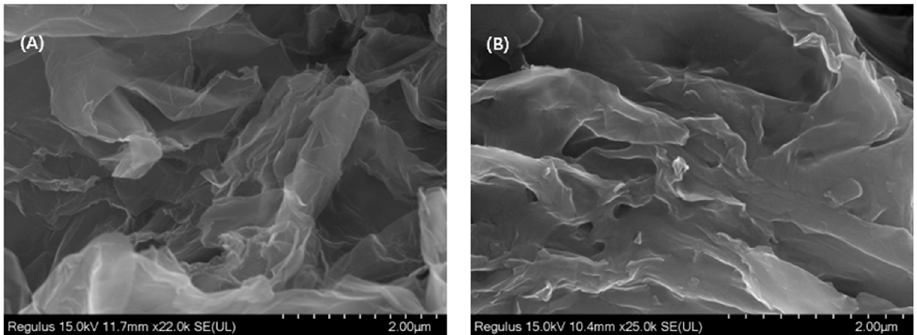
Figure 1. SEM images of ( A ) 3D–rGO and ( B )